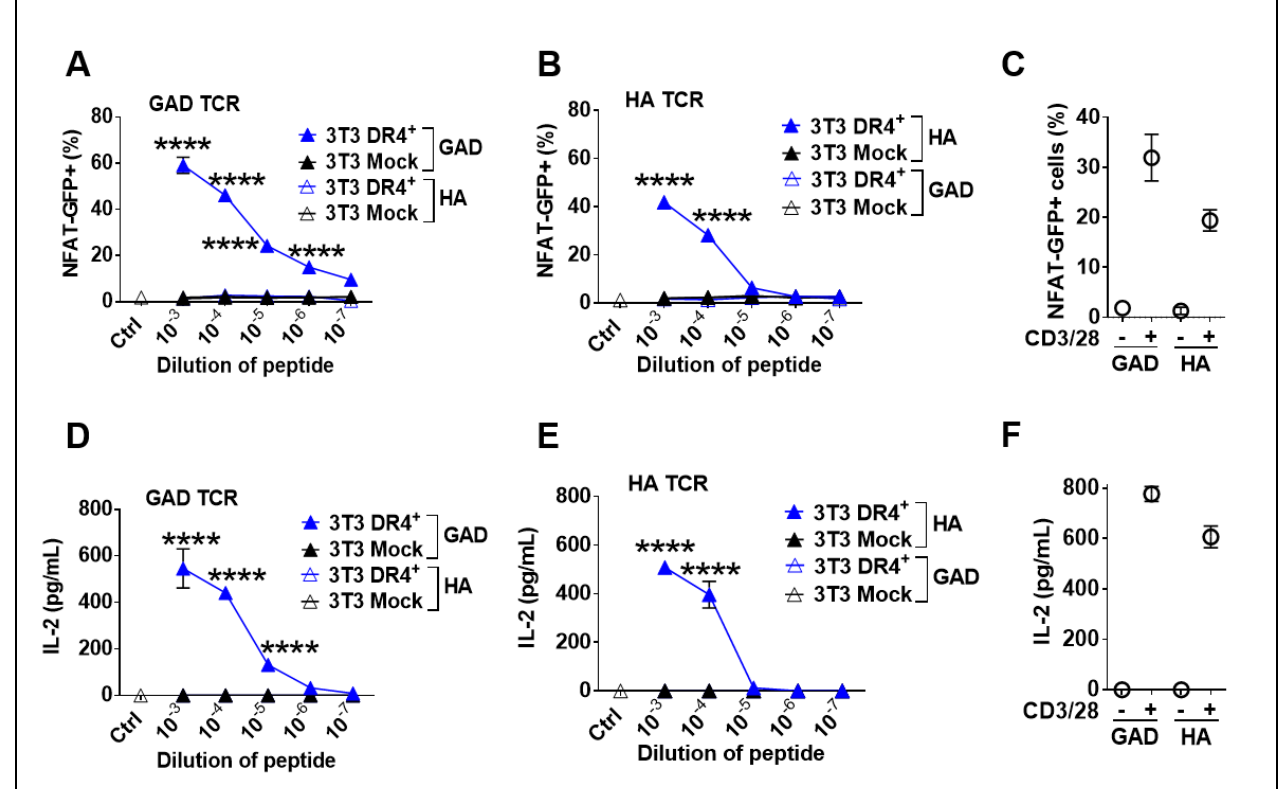
Figure 4. Functional analysis of DR4 dimer on 3T3 cells to present antigens to DR4-restricted 58-T cells leading to their activation. ( A , B ) Co-culture of transduced DR4 + 3T3 or Mock 3T3 cells with 58 T cell line (expressing GAD or HA TCR together and NFAT-GFP reporter) and stimulation with different dilutions of glutamate decarboxylase (GAD) peptide ( A ) or hemagglutinin (HA) peptide ( B ) or anti-CD3/CD28 (positive control, ( C ) for 24 h. Quantification of glowing GFP + cells was performed by flow cytometry. Secreted IL-2 was measured in supernatant of GAD TCR cells ( D ), HA TCR cells ( E ), and cells treated with anti-CD3/28 ( F ). **** p < 0.0001 by Two-way ANOVA with Sidak ’ s multiple comparison test (n = 3). Data are representative of two independent experiments.